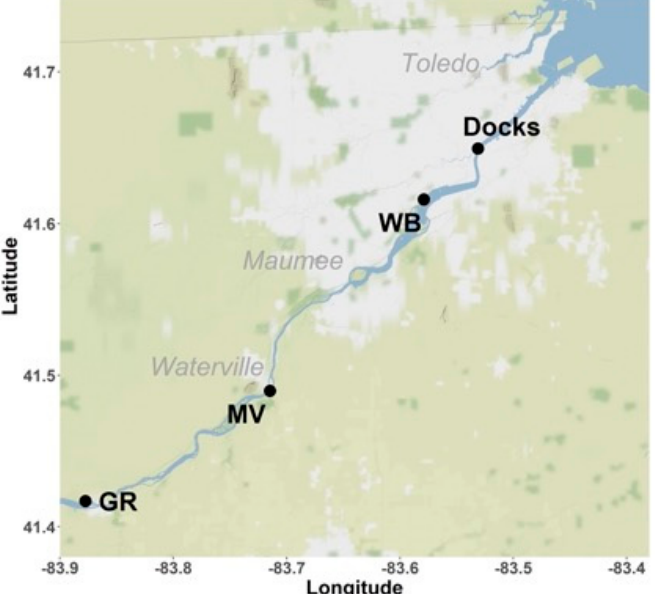
Figure 1. Map of the Maumee river watershed showing the four sampling sites. Lake Erie is seen here on the top right corner where the Maumee river drains into the lake. Site identifier as follows: GR: Grand Rapids; MV: Miltonville; WB: Walbridge Park .